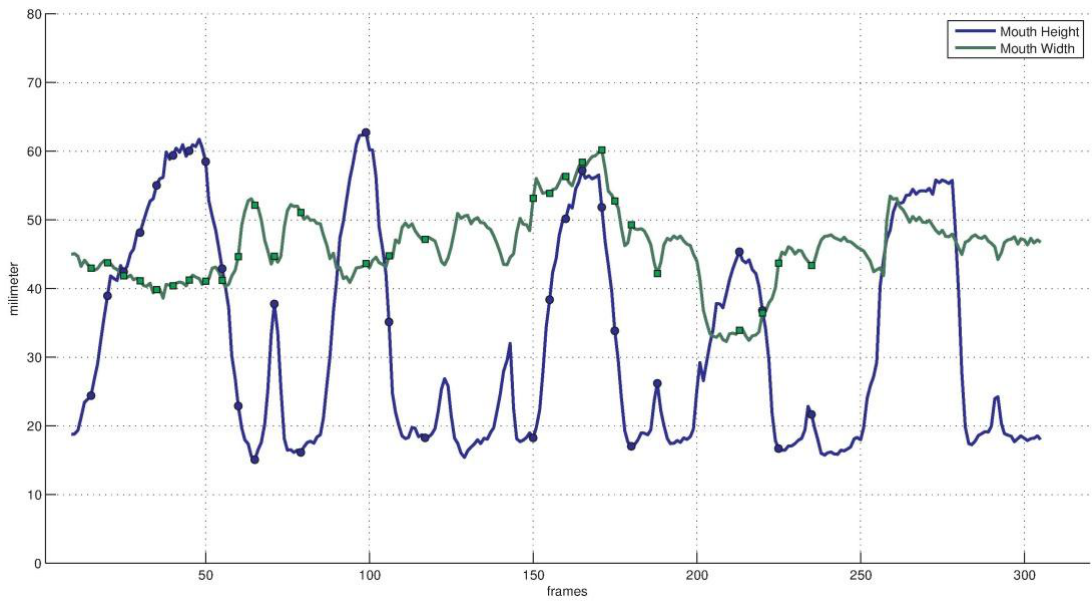
Figure 9. Mouth movement curves in metric of millimetre. The green curve is the mouth width tracking result while the blue curve is the mouth height tracking result.